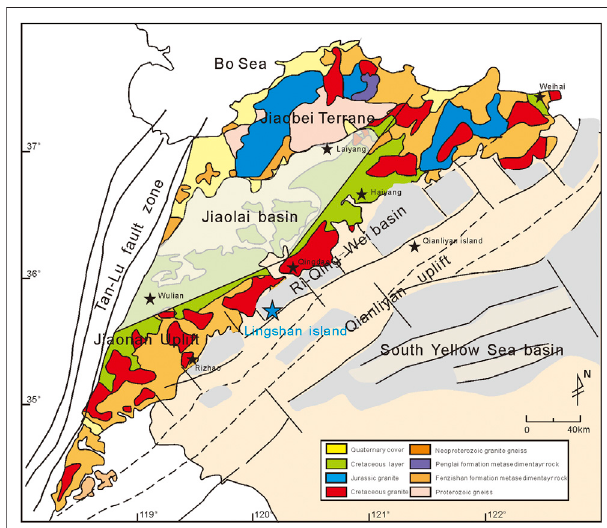
FIGURE 1 | Geological map of Ri-Qing-Wei basin and related area (modi fi edfrom Zhou et al., 2015; Liu et al., 2019).